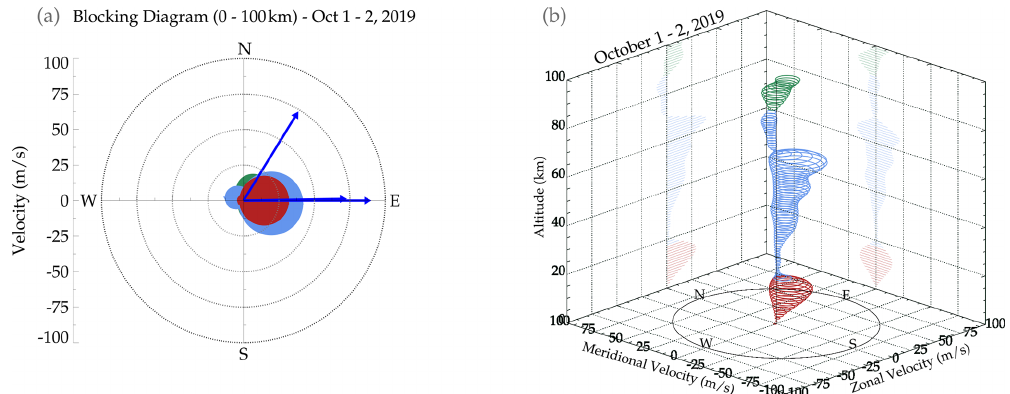
Figure 5. (a) The 2D blocking diagram and (b) the 3D blocking diagram. The wind characteristics from 0–17km are represented by red rings, from 18–87km by light-blue rings, and above 87km by green